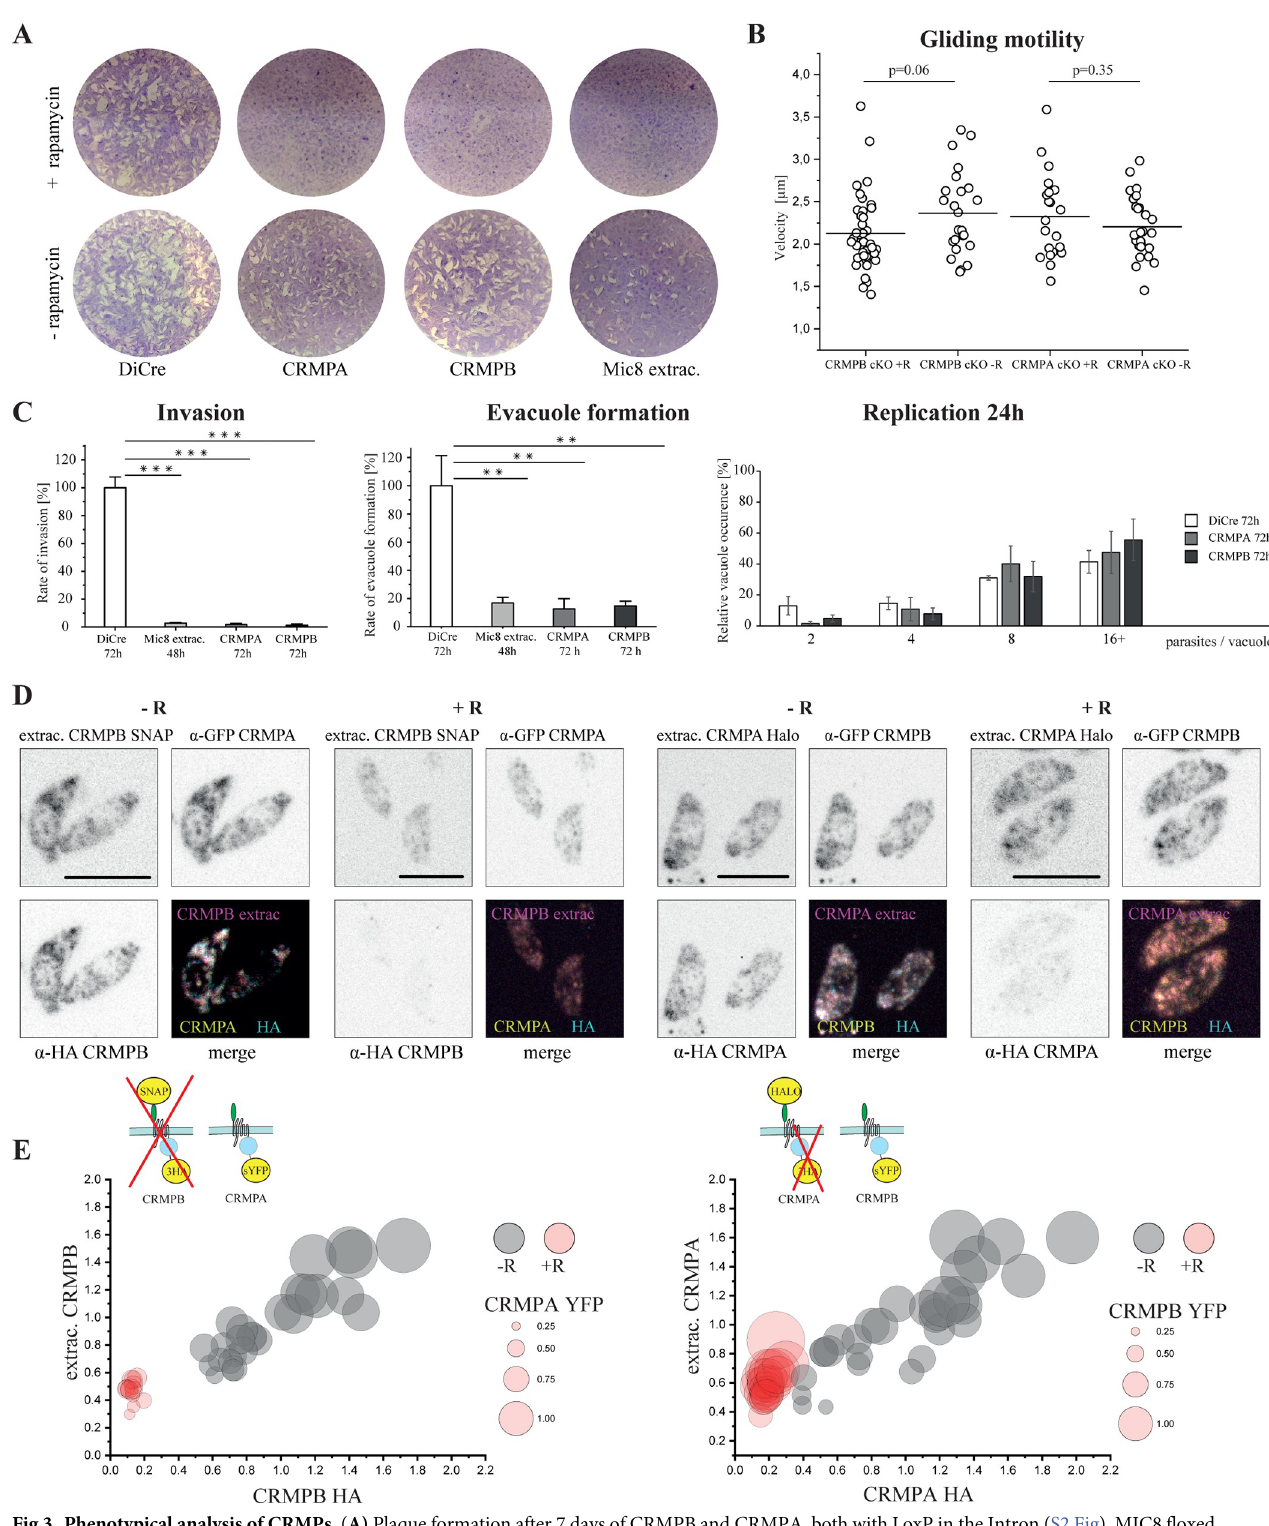
Fig 3. Phenotypical analysis of CRMPs. ( A) Plaque formation after 7 days of CRMPB and CRMPA, both with LoxP in the Intron (S2 Fig). MIC8 floxed extracellular domain (RH-MIC8extrac. floxed ) is shown as positive control. Representative plaque assays are shown. ( B) Gliding motility was assessed on FBS- coated dishes 3 days post-induction using rapamycin. The speed of tachyzoites moving for 10 or more consecutive seconds is shown. Statistical analysis: two-